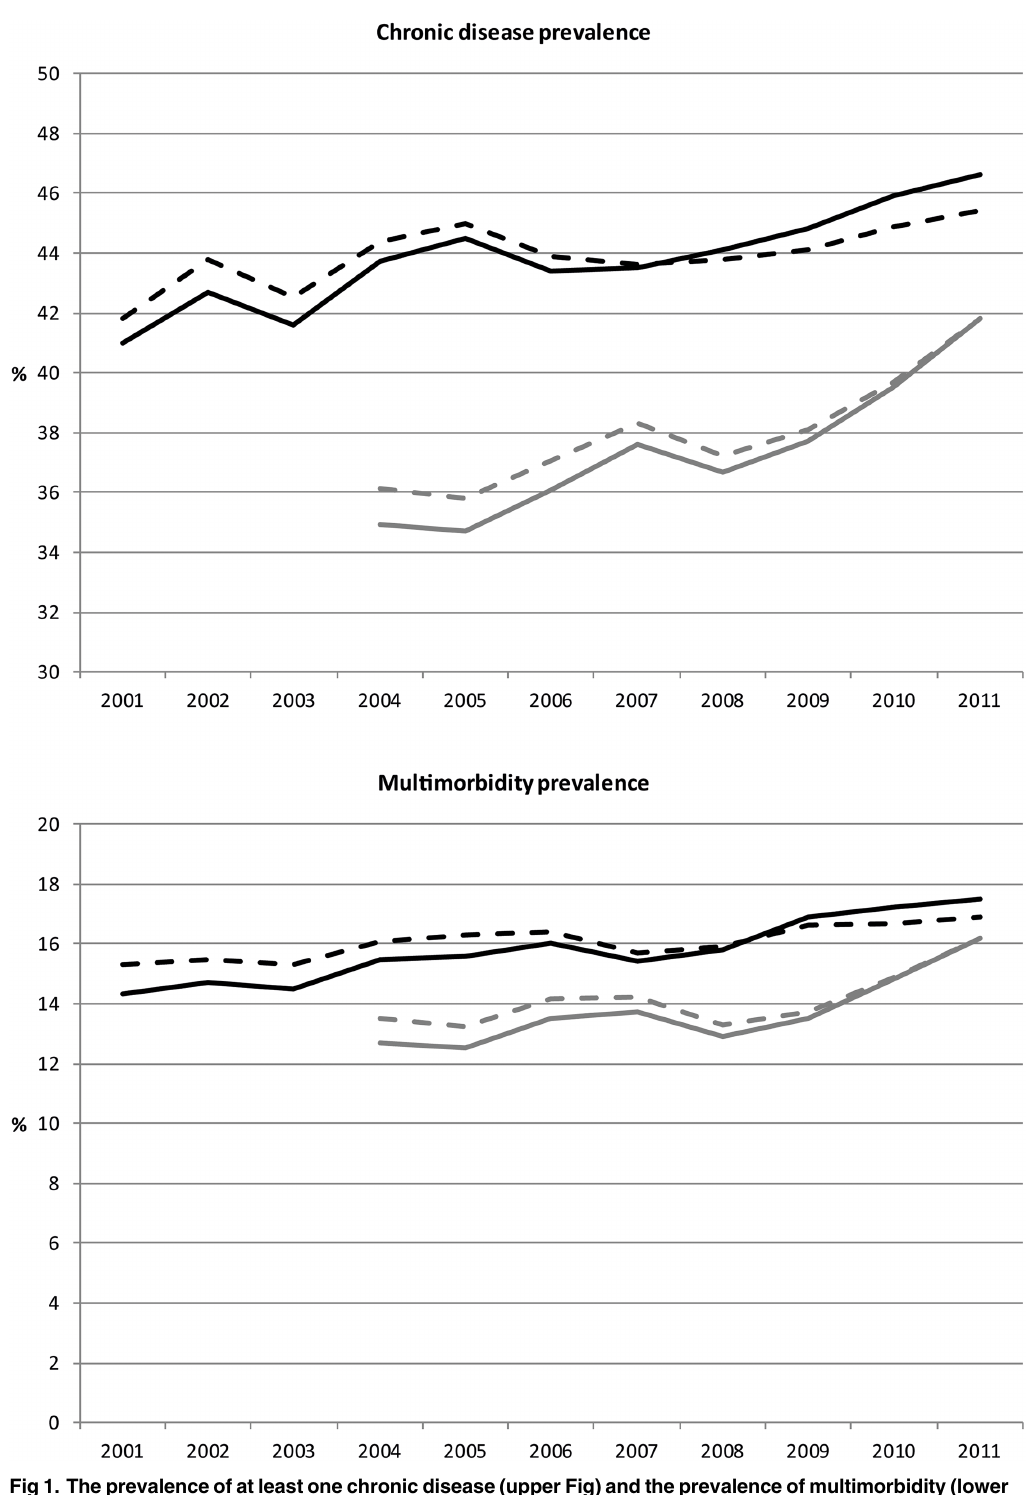
Fig 1. The prevalence of at least one chronic disease (upper Fig) and the prevalence of multimorbidity (lower Fig) in the general population of 25 years and older, over the period 2001 – 2011. Legend: grey solid line = GP registered diagnoses; grey dotted line = GP registered diagnoses, prevalence standardized for the Dutch population in 2011; black solid line = self-reported chronic diseases; black dotted line = self-reported chronic diseases, prevalence standardized for the Dutch population in